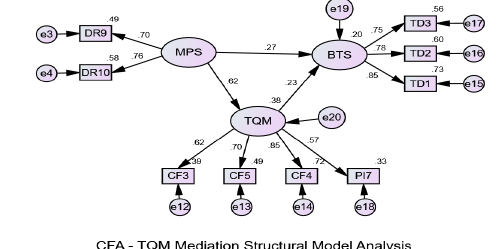
Fig. 3. Path model (Coefficients and model fit